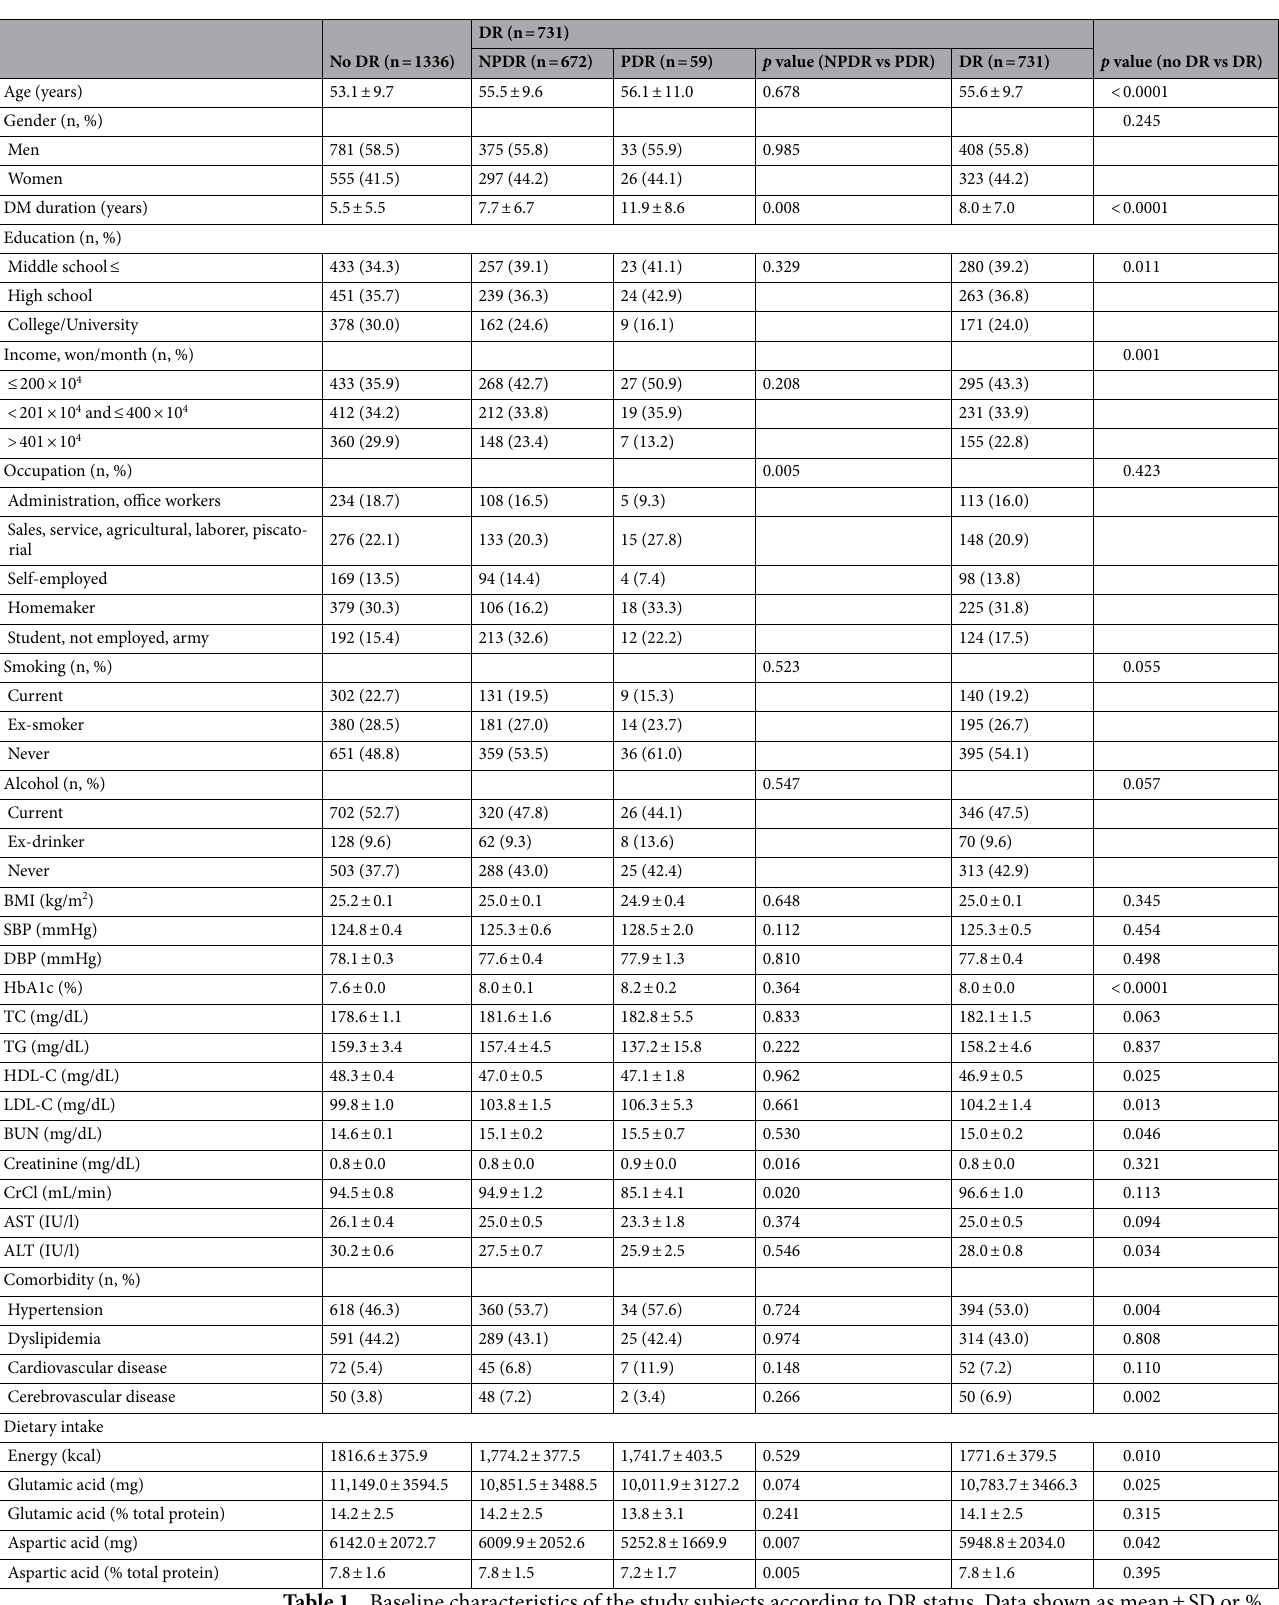
Table 1. Baseline characteristics of the study subjects according to DR status. Data shown as mean ± SD or %, by Chi-squared test or general linear model (GLM). DR diabetic retinopathy; NPDR isolated